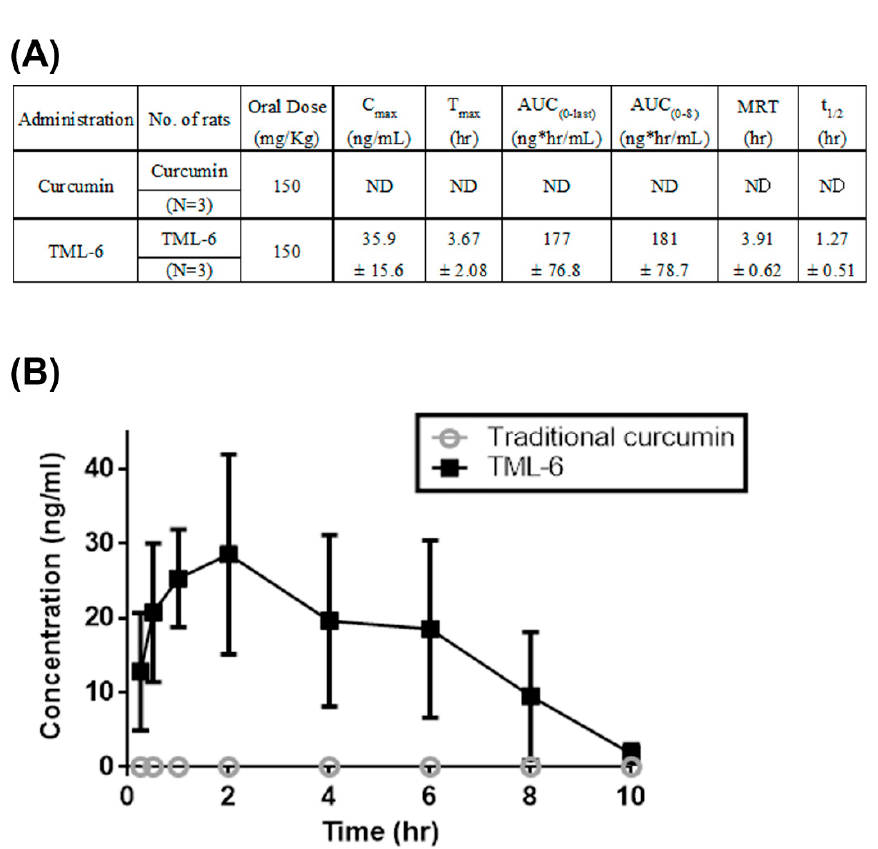
Figure 5. TML-6 exhibited significantly improved bioavailability as compared to traditional curcumin. (A) Summary of the absorption data on traditional curcumin and TML-6 in male Sprague–Dawley rats after oral administration of curcumin and TML-6 of 150 mg/kg. Values represented the mean ± SD of three rats in each treatment group. Abbreviations: ND, not detectable. (B) Bioavailability (serum concentration) of traditional curcumin and TML-6 was plotted against the time after oral administration to rats. The pK of curcumin was almost non-detectable (ND), consistent with the previous reports. Cmax indicates the observed maximum blood concentration and the time to reach the maximum blood concentration, while Tmax was determined directly from the experimental values. AUC (0-last) indicates the area under the concentration–time curve from time 0 to the last measurable concentration and MRT indicates the mean residence time.